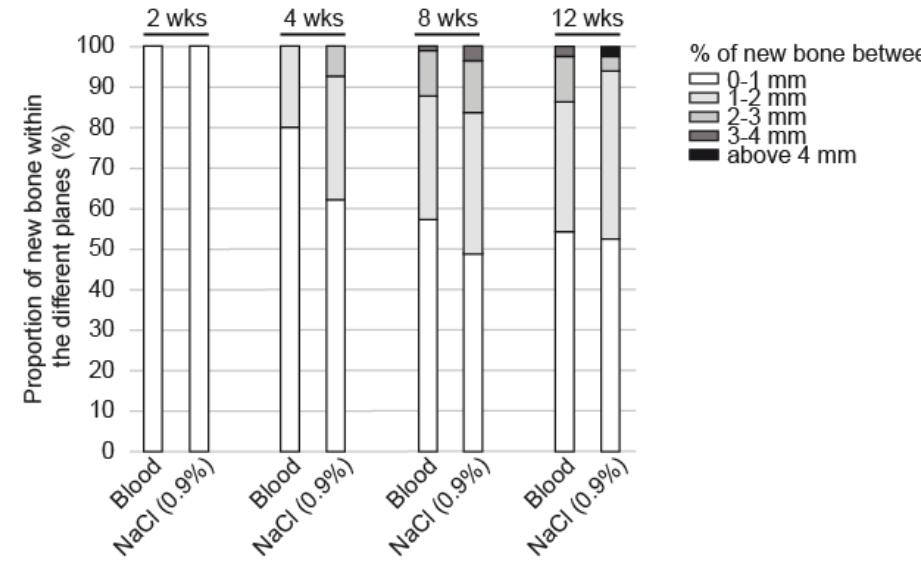
Figure 6. Proportion of new bone volume in the cylinders filled with DBBM-C scaffolds either pre-treated with blood or NaCl 0.9% segmented in 5 horizontal planes of 1 mm in height at 2, 4, 8 and 12 weeks.